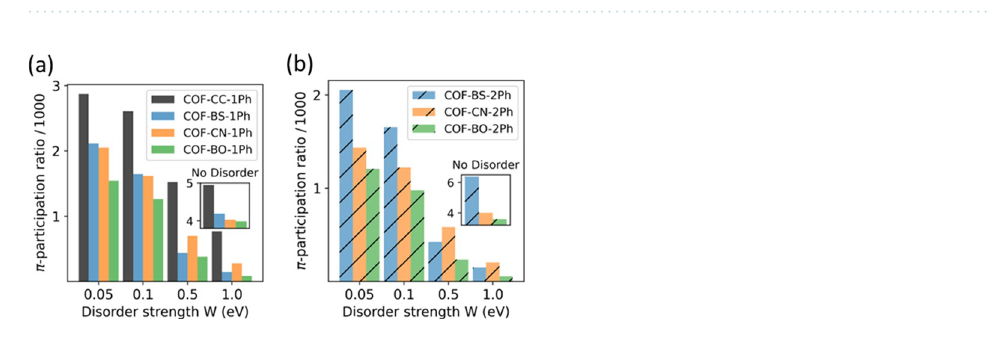
Figure 11. DOS and π -DOS for COF-BS-1Ph with different amounts of Anderson disorders W . Disorder-free case reproduced from Fig. 5a for comparison. Colored bars and energy scale are the same as in Fig. 5. Labels “D” show the Dirac points of the hcb-tri group.